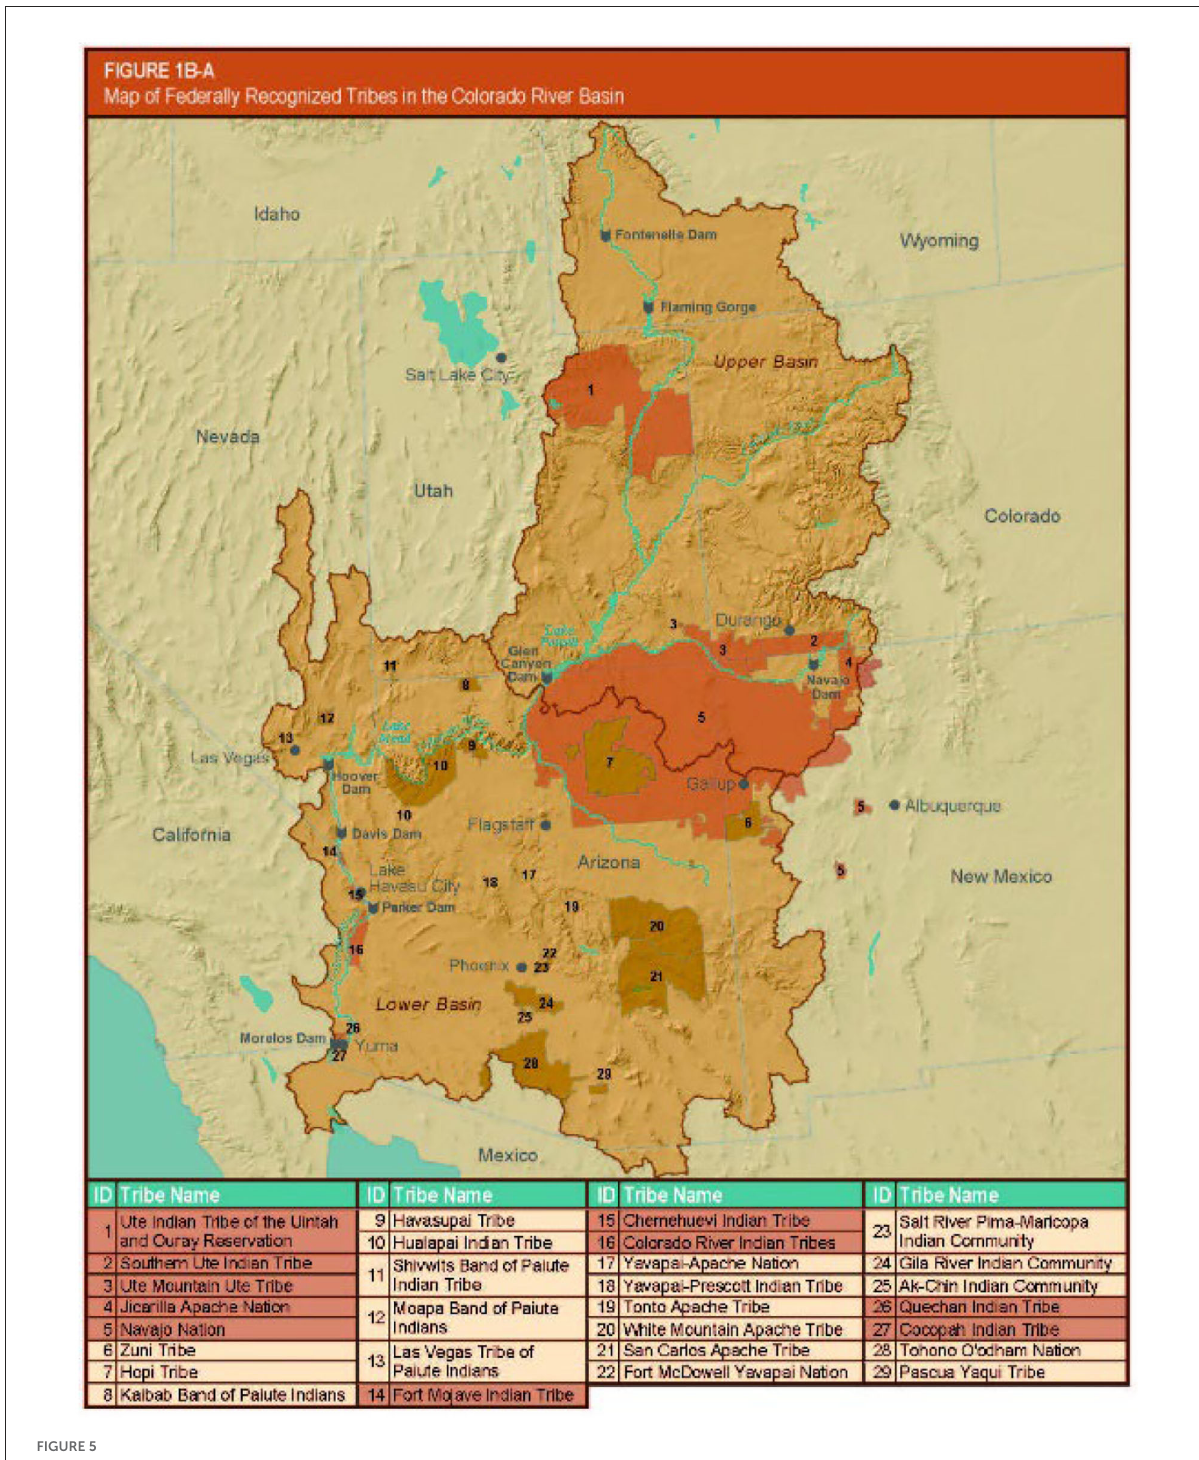
FIGURE5 Map of federally recognized tribes in the Colorado River basin [U.S. Bureau of Reclamation map. Available online at: https://www.usbr.gov/lc/ region/programs/crbstudy/tws/docs/Appx%201B%20Federally%20Rec%20Tribe%2012-13-2018.pdf (accessed December 16, 2022)].